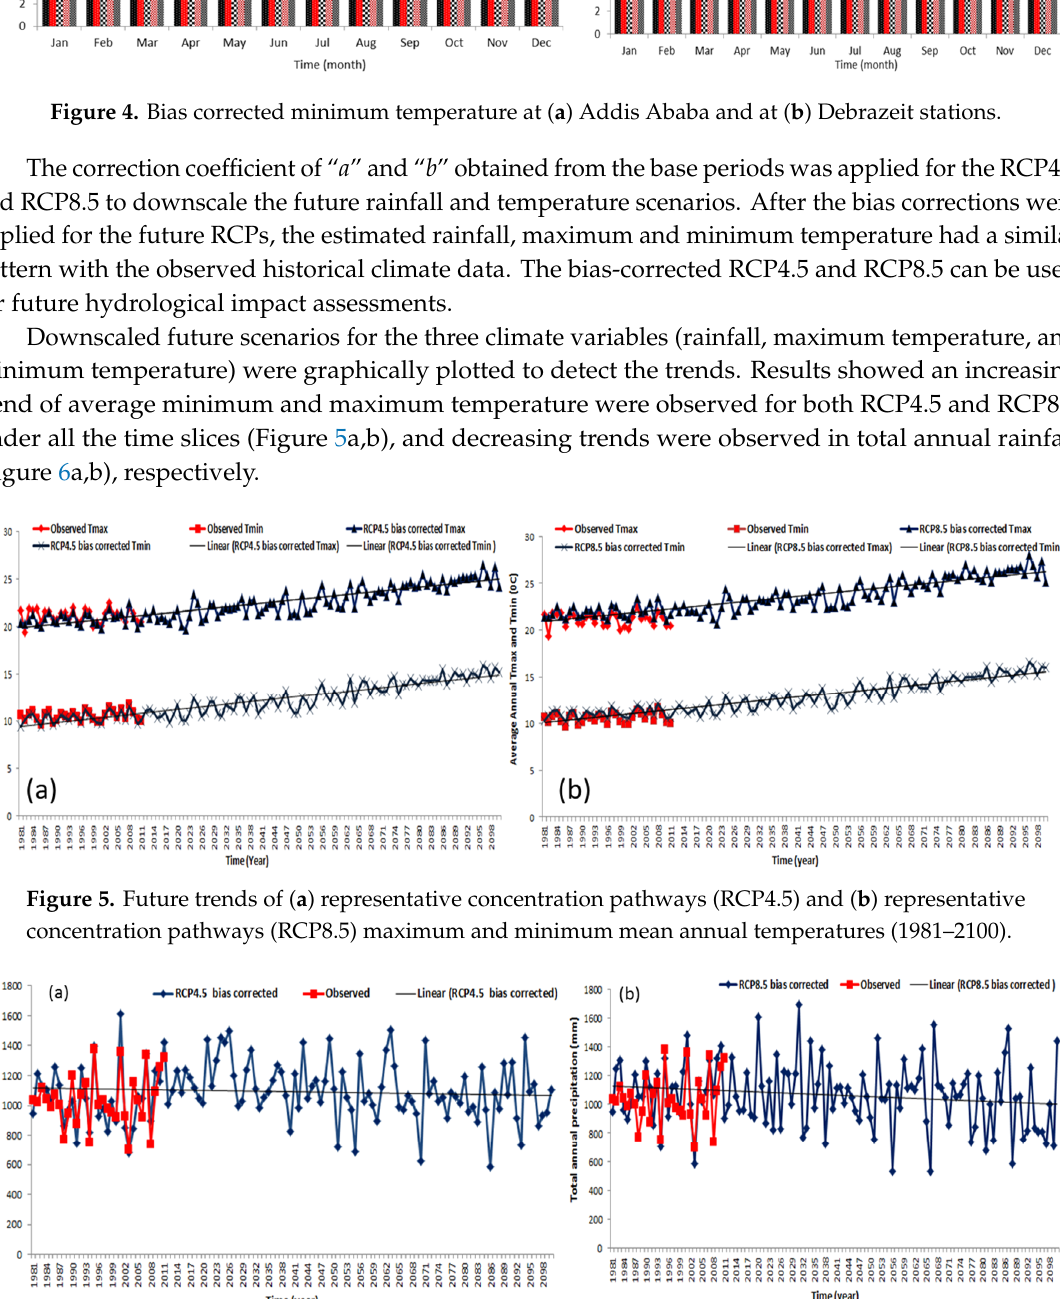
Figure 4. Bias corrected minimum temperature at ( a ) Addis Ababa and at ( b ) Debrazeit stations.